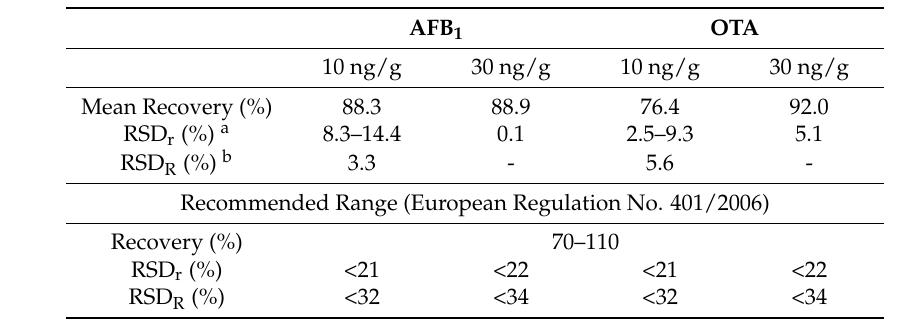
Table 4. Accuracy and precision of the analytical methods for aflatoxin B 1 and ochratoxin A for spiking levels of 10 ng/g and 30